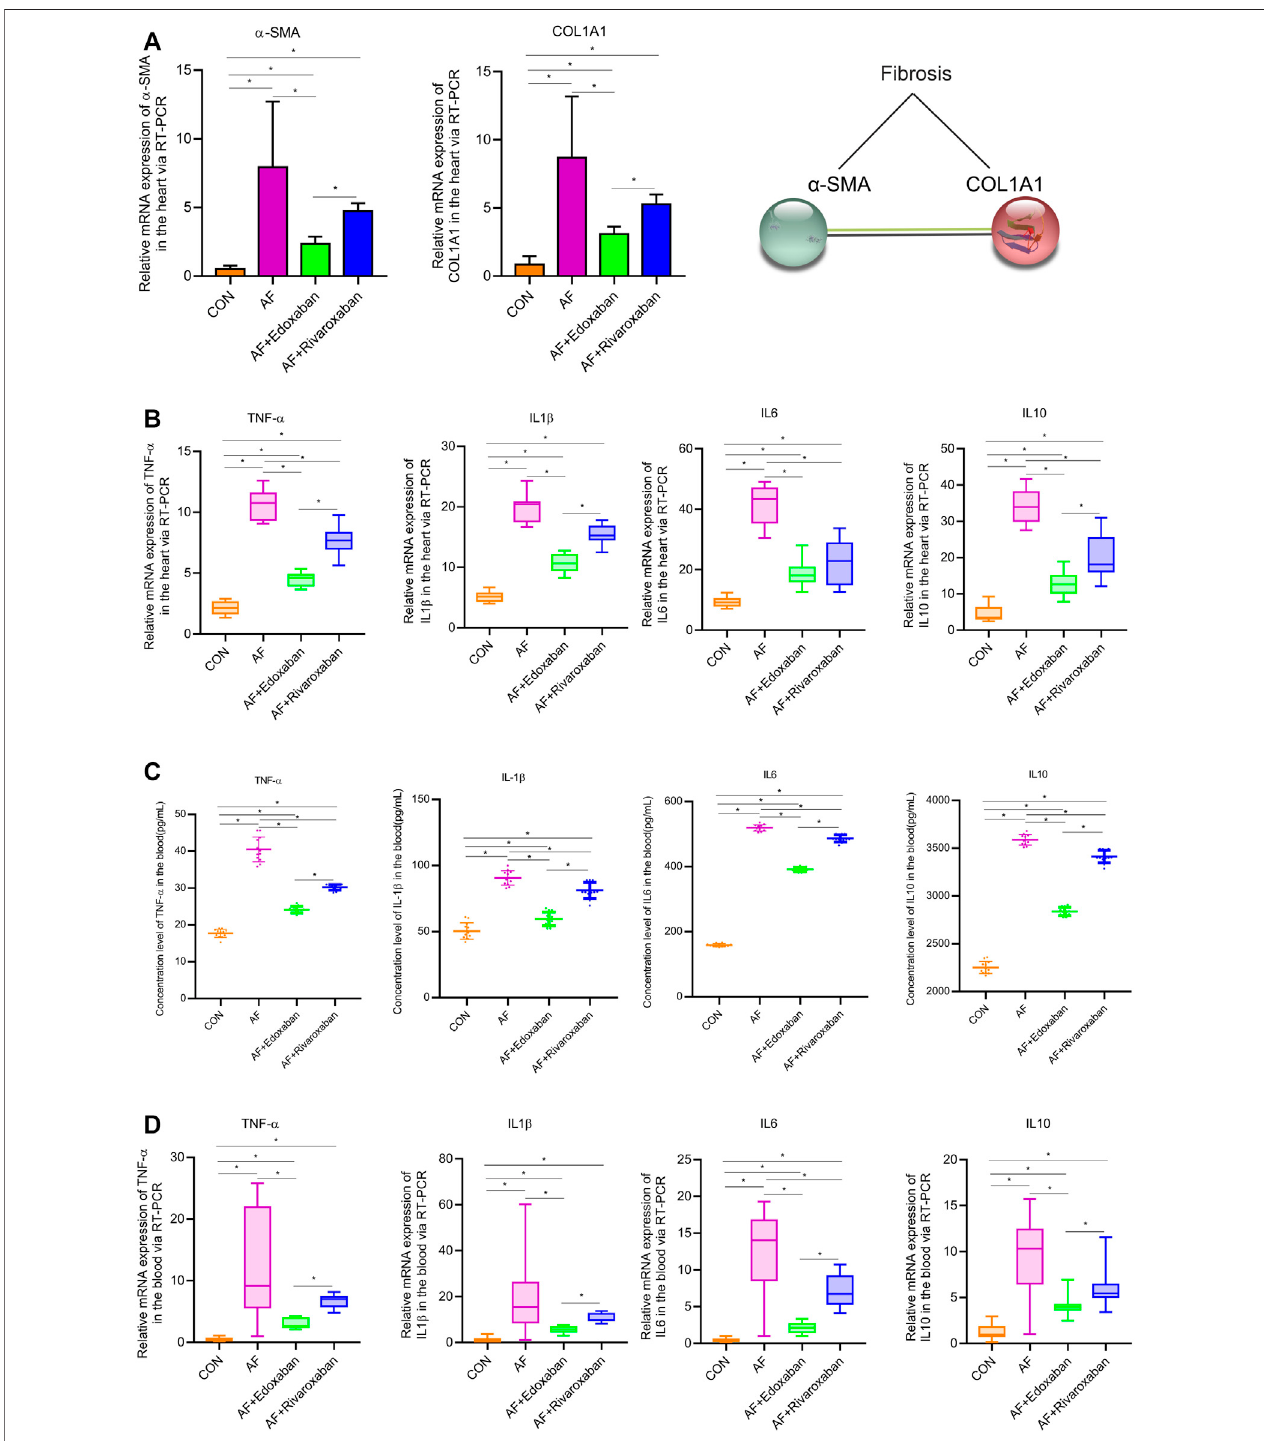
FIGURE 5 | mRNA levels of α -SMA and COL1A1 via the RT-PCR, and edoxaban reduced the level of in fl ammation in the heart of the AF mouse model. (A) Compared with the AF group, the mRNA expressions of α -SMA and COL1A1 in the cardiac muscle tissue were downregulated in the AF + edoxaban group and AF + rivaroxaban group ( p < 0.05). (B) After using edoxaban or rivaroxaban, the mRNA expressions of in fl ammatory biomarkers (TNF- α , IL-1 β , IL-6, and IL-10) in the heart were signi fi cantly decreased via the RT-PCR ( p < 0.05). (C) Through the ELISA, the in fl ammatory biomarkers (TNF- α , IL-1 β , IL-6, and IL-10) in the blood were upregulated in the AF group than in the AF + edoxaban group. (D) In fl ammatory biomarkers (TNF- α , IL-1 β , IL-6, and IL-10) in the blood were also detected via the RT- PCR assay. Compared with the AF group, the mRNA expressions of TNF- α , IL-1 β , IL-6, and IL-10 were downregulated in the AF + edoxaban group and the AF + rivaroxaban group ( p <